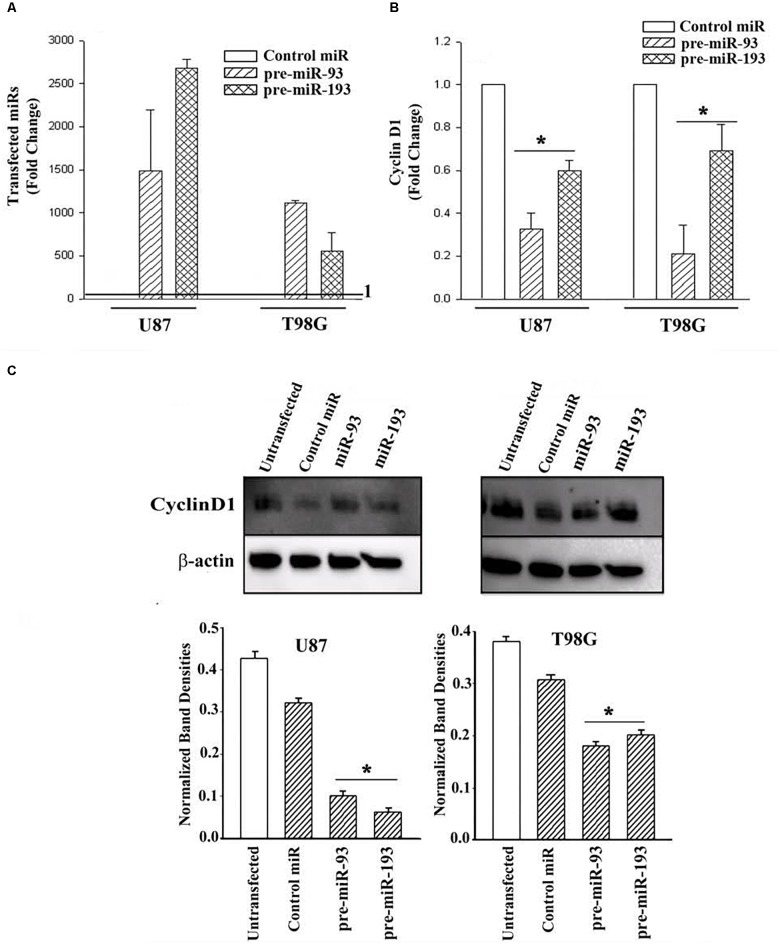
Cyclin D1 expression in miR-93/-193 GBM transfectants treated with TMZ. (A) Real time PCR for control miR, miR-93 and miR193 with RNA from U87 and T98G, transfected with the respective pre-miRs. The results are presented as the mean (±SD, n = 3) fold change of control. The controls for both primers are set at values of 1. (B) The transfectants in “A” were studied for cyclin D1 and the results are presented as mean fold change (±SD, n = 3) over the transfectants with control pre-miR. The control pre-miR was assigned values of 1. (C) The transfectants in “A” were treated with 200 μM TMZ. After 72 h, the viable cells were studied for Cyclin D1. An additional control with untransfected cells was included in the blot. The mean (±SD, n = 3) normalized band densities are shown in the graphs. ∗
p < 0.05 vs. control miR.